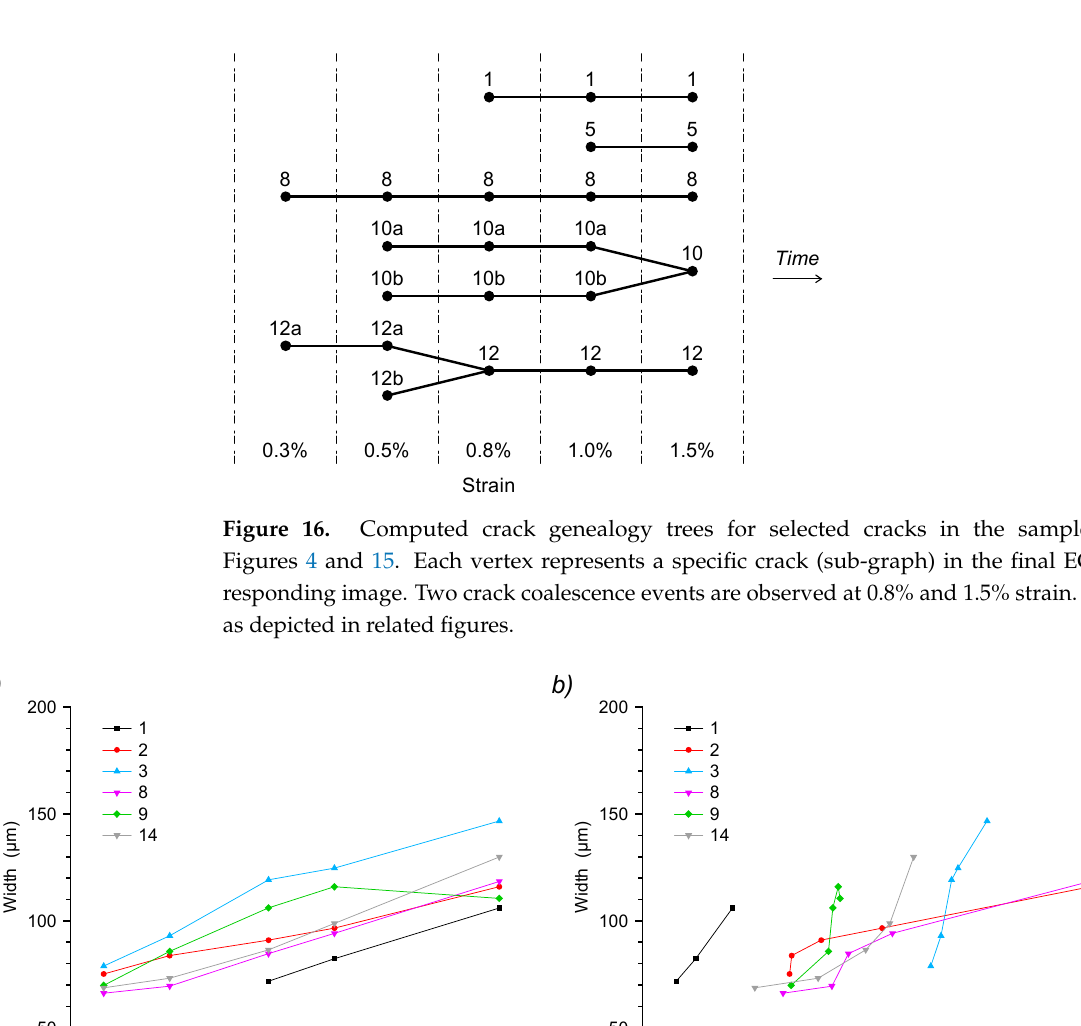
Figure 16. Computed crack genealogy trees for selected cracks in the sample shown in Figures 4 and 15. Each vertex represents a specific crack (sub-graph) in the final EG of the corresponding image. Two crack coalescence events are observed at 0.8% and 1.5% strain. Crack labels as depicted in related figures.